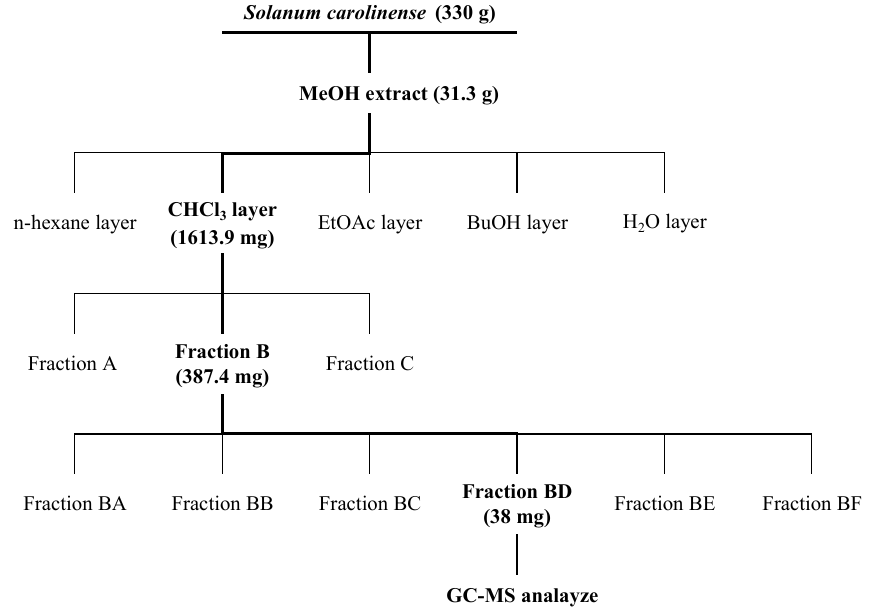
Figure 1. The process of separating and purifying allelochemical of Solanum carolinense .